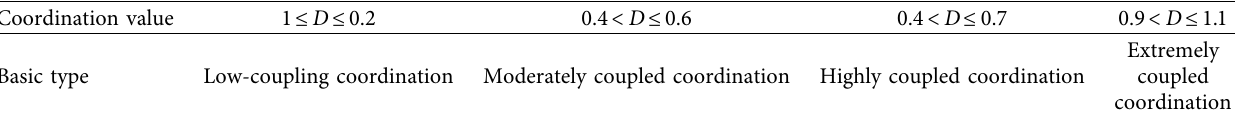
Table 2: The distribution of types of collaboration and the connection between digital marketing and sustainable development. Coordination value